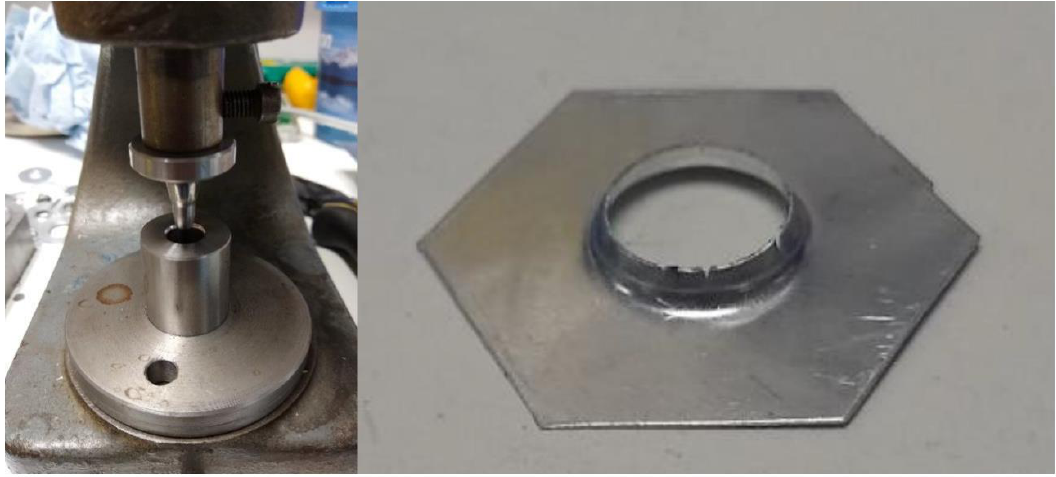
Figure 5. Fin collar forming swaging tool ( left ) and the resulting fin ( right ).